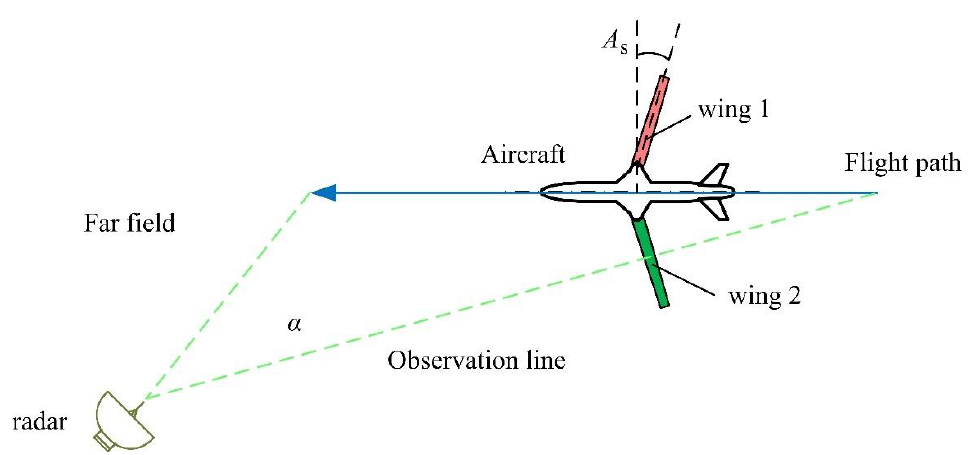
Figure 2. Schematic of aircraft with variable sweepback wings in staged flight.